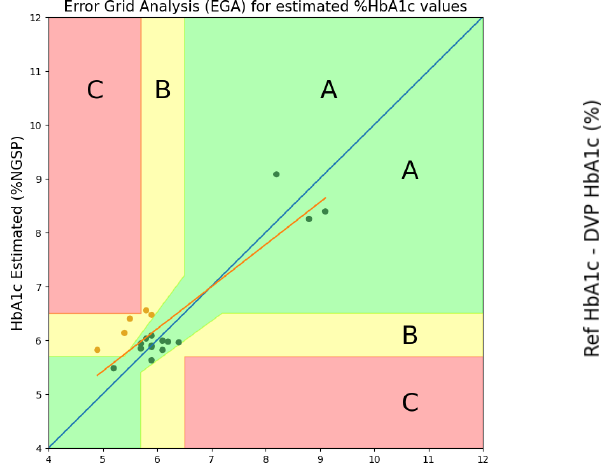
Figure 5. EGA and Bland–Altman analysis for the HbA1c estimation with the blood vessel model (considering both ratio and value calibrations). 4.2. Whole Finger Model After performing the ratio calibrations considering the whole finger model, the re- sults are shown in Figure 6; from the EGA, Zone A contained 16 samples (80%), Zone B contained 4 samples (20%), and Zone C contained 0 samples (0%). The Bland–Altman analysis indicated that the bias was − 0.0718 ± 0.9260, and the limits of agreement ranged from − 1.00 to 0.85. The limits of agreement of the whole finger model were smaller than